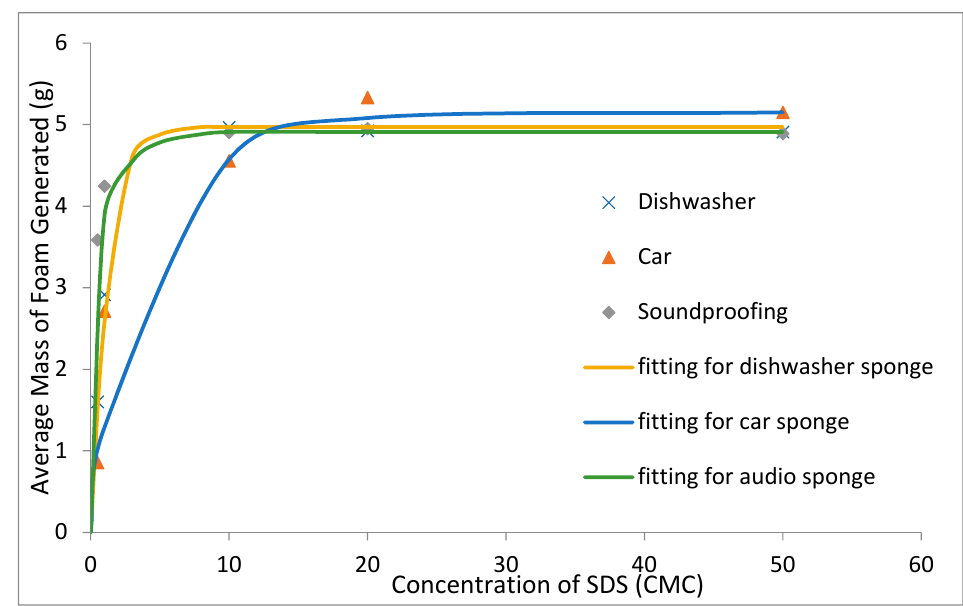
Figure 10. The dependency of surfactant concentration on foam generated for the different sponge types investigated using distilled water, where the fitting is calculated using Equation (3). Table 8. Liquid volume fraction for each concentration of each of the sponges investigated using distilled water.